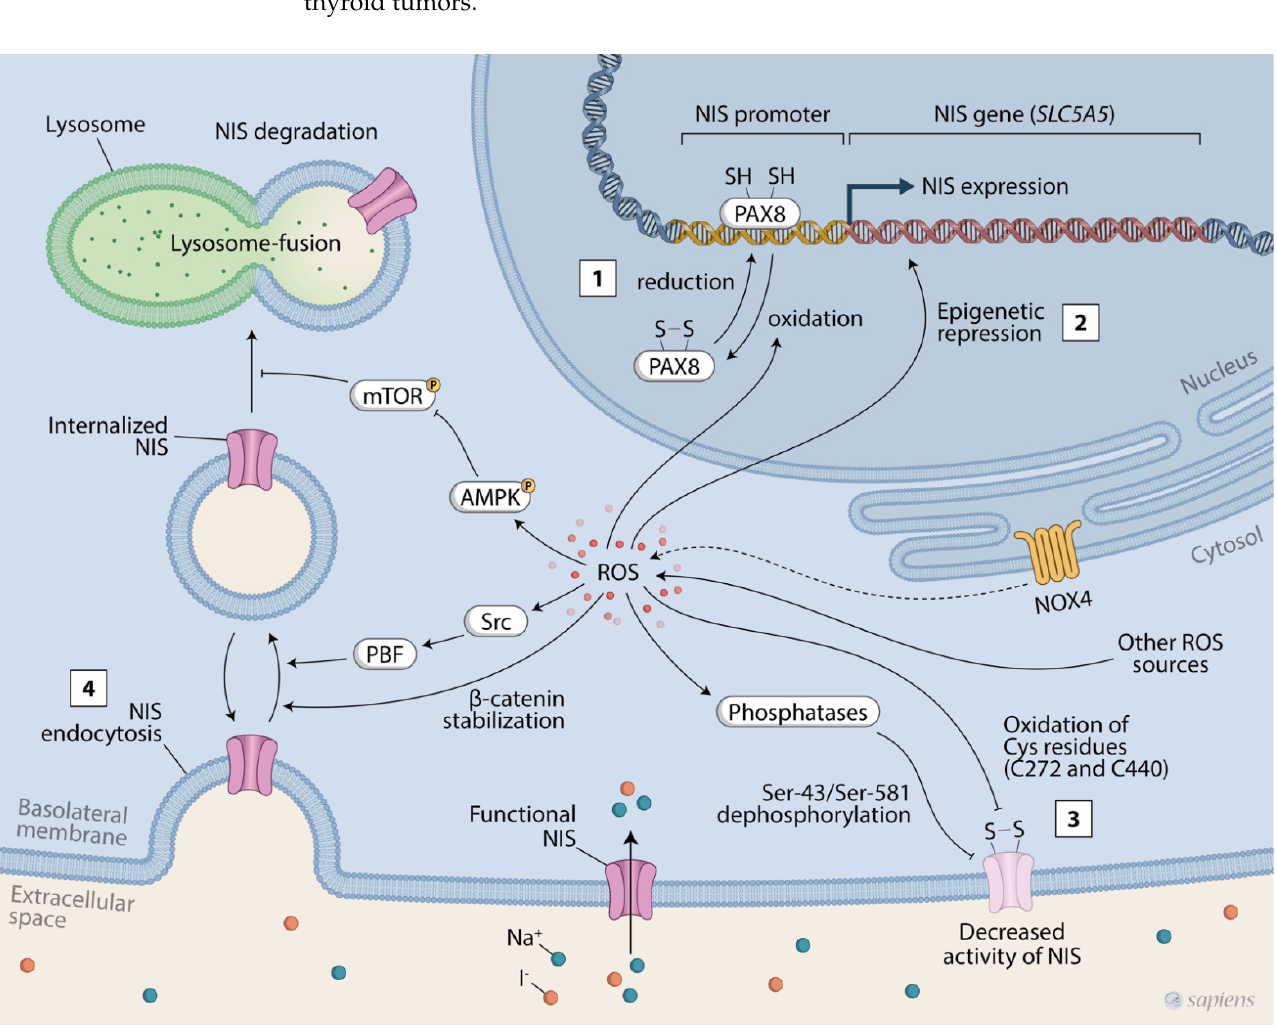
Figure 2. Mechanisms hypothetically involved in NIS redox regulation: (1) PAX8 oxidation results in reduced PAX8 DNA binding activity and the repression of NIS transcription; (2) ROS might mediate alterations of epigenetic events also promoting NIS transcriptional repression; (3) ROS might directly oxidize NIS protein or indirectly change the phosphorylation pattern of NIS protein, resulting in decreased NIS activity; (4) ROS might activate pathways involved in NIS endocytosis and autophagy, promoting NIS internalization and degradation.